Question: According to this chart, does the measure grow or shrink?
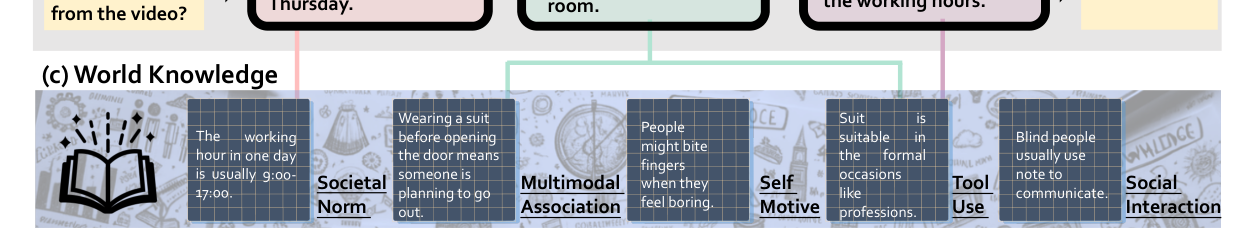
Answer: increasing